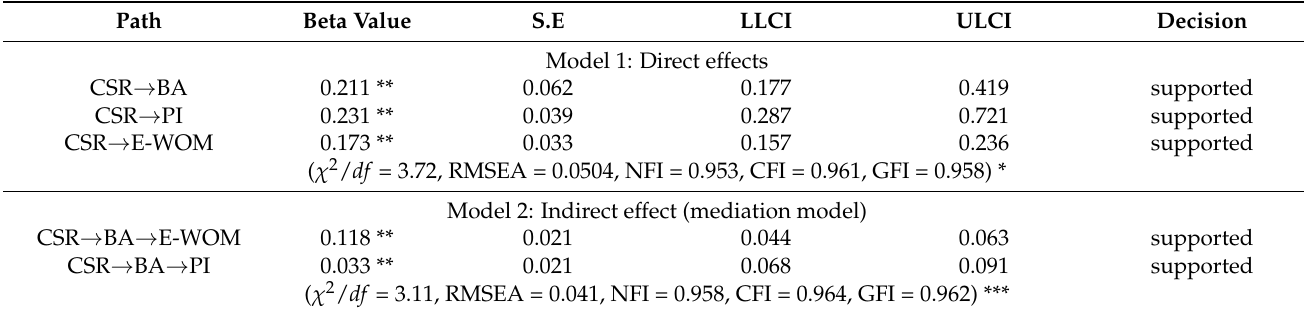
Table 4. Results of hypotheses